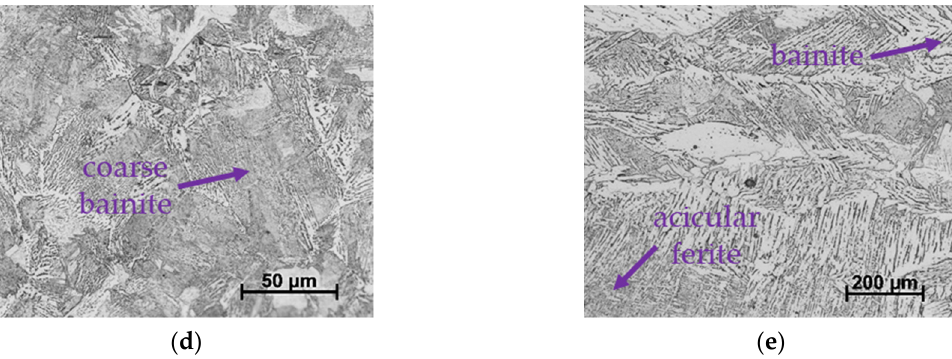
Figure 3. Microstructure of P265GH steel: ( a ) BM, ( b ) ICHAZ, ( c ) FGHAZ, ( d ) CGHAZ, and ( e ) WM.